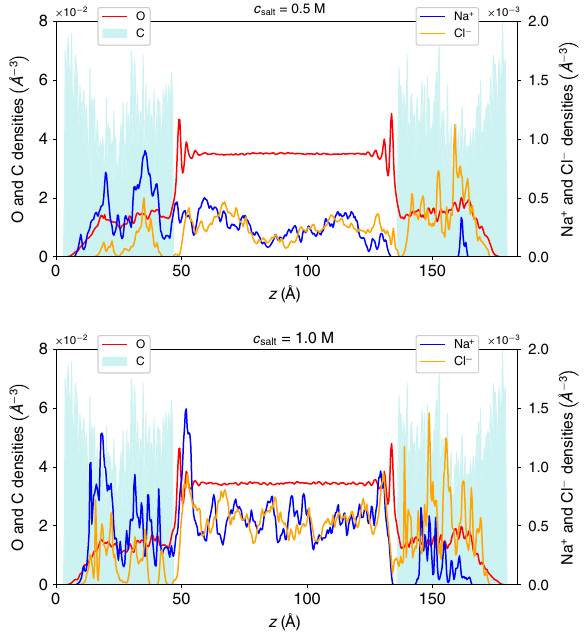
FIG. 3. Density profiles along the simulation cell, for an average salt concentration of 0.5 and 1 . 0 M (top and bottom, respectively). The negative (resp. positive) electrode is on the left (resp. right) side of the cell.